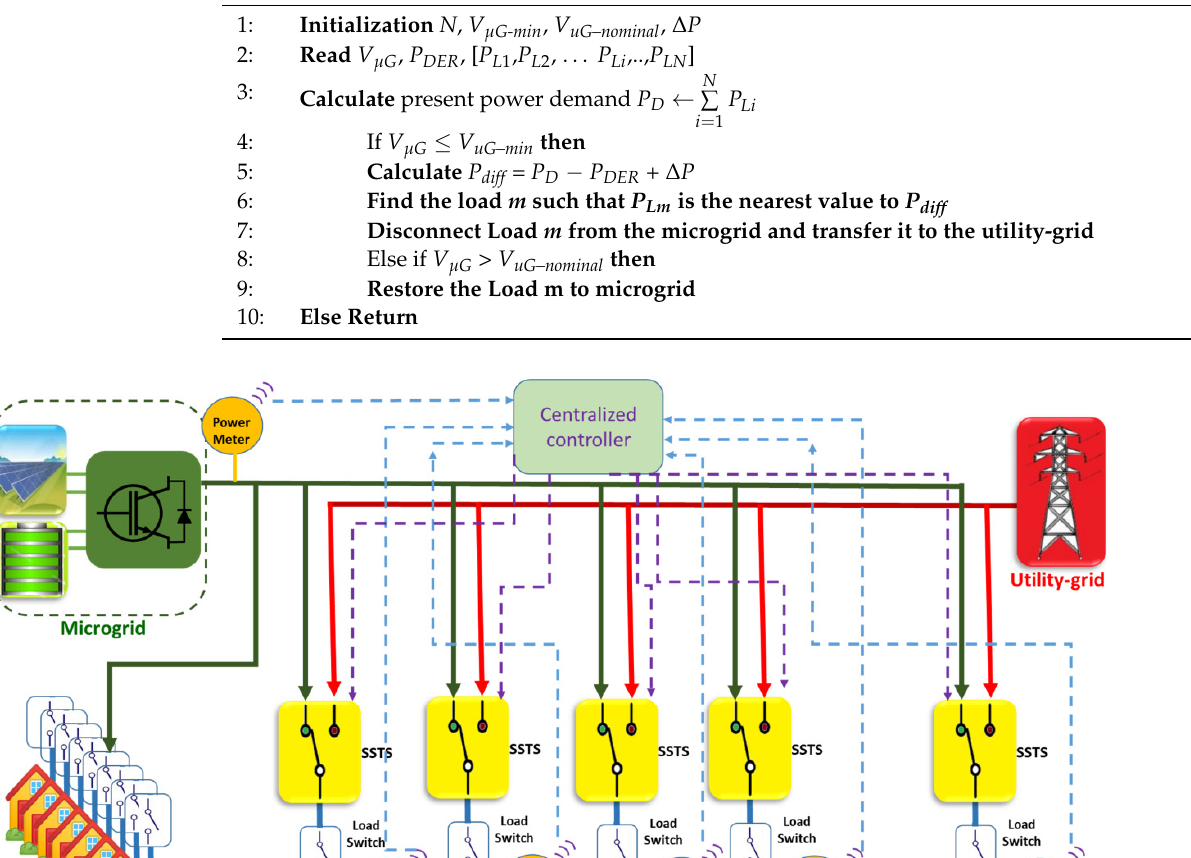
Algorithm 3 Pseudocode of loads selecting and transferring to the utility-grid